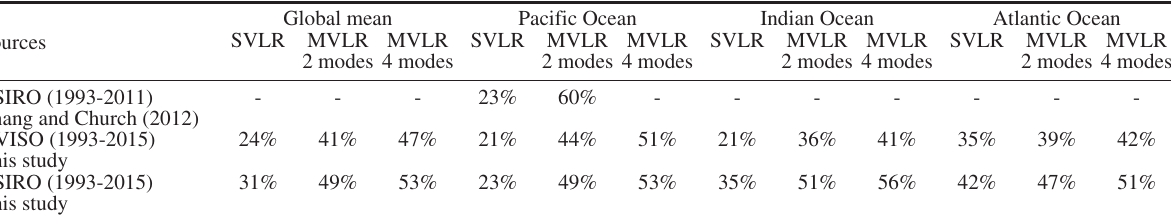
Table 2. – Percentage of explained covariance in regression models (SVLR and MVLR with two dominant modes, and MVLR with all four dominant modes) using different datasets. Sources